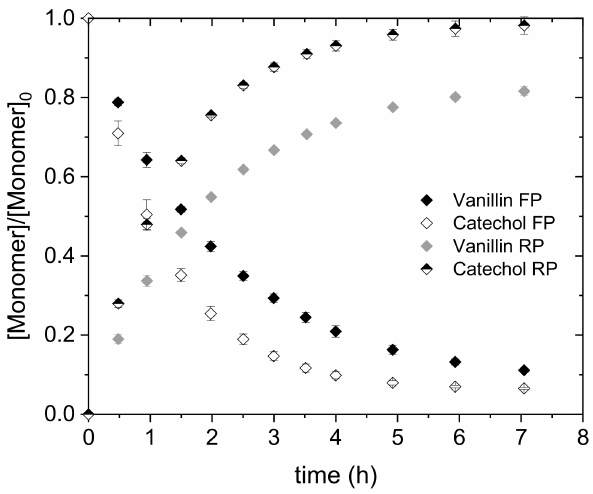
Figure 7. Transport of vanillin and catechol in both phases. FP: mixture of both monomers with a concentration of 100 mg/L each one in citrate buffer pH 4; OP: 0.48 mol/L Cy923; RF: 0.50 mol/L